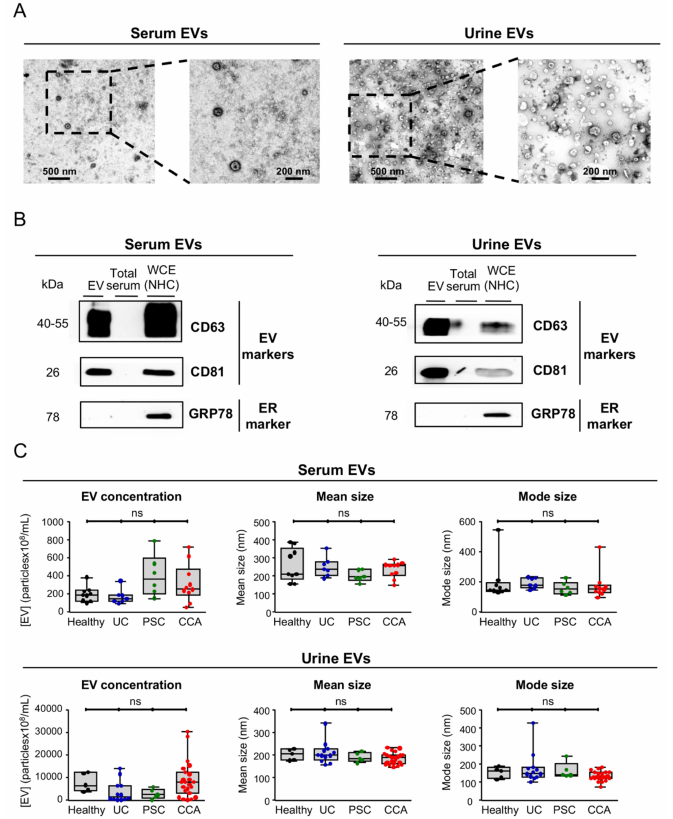
Figure 1. Characterization of serum and urine EVs from patients with CCA, PSC, UC, and healthy controls. In order to validate the protocol for EVs isolation, we used blood serum and urine from healthy individuals. ( A ) TEM images of blood serum (left) and urine (right) EVs from healthy individuals showcasing the typical round shape (~150 nm) and morphology. ( B ) Representative immunoblots of the EV markers CD63 and CD81 (positive controls) and GRP78 (negative control) from EVs isolated from serum (left) and urine (right) of healthy individuals that indicate an enrichment of EV markers and a complete absence of the endoplasmic reticulum (ER) marker GRP78, compared to total serum and whole cell extracts (WCEs) of normal human cholangiocytes (NHC). ( C ) Nanoparticle tracking analysis (NTA) of serum (up) and urine (down) EVs revealing no di ff erences in EV concentration between CCA, PSC, UC, and healthy individuals and a similar EV mode (~180